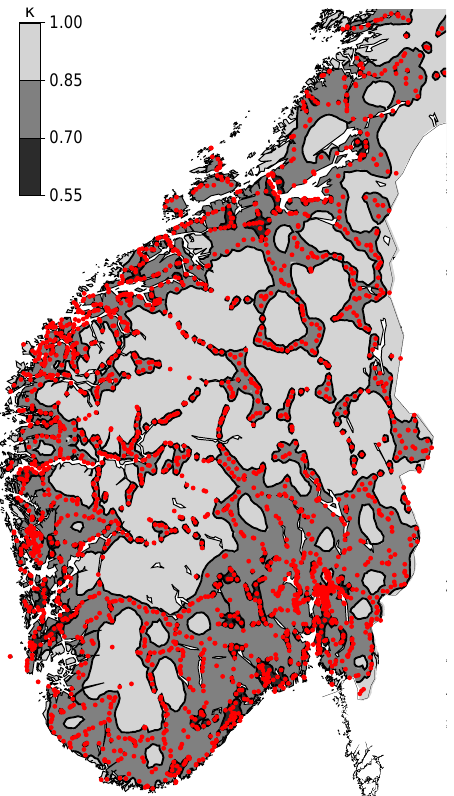
Figure 5: The relative reduction 1 − κ in uncertainty due to collo- cation, for spatial separations of ∆ = 10 km, can be inferred from the shown distribution of κ given by Eq. (35). Normal heights that realize NN2000 are represented by red dots (the